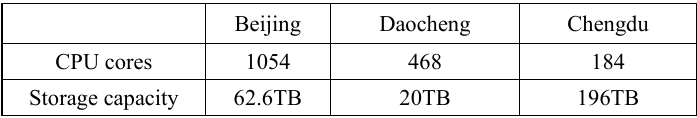
Table 2. Resources for the LHAASO distributed